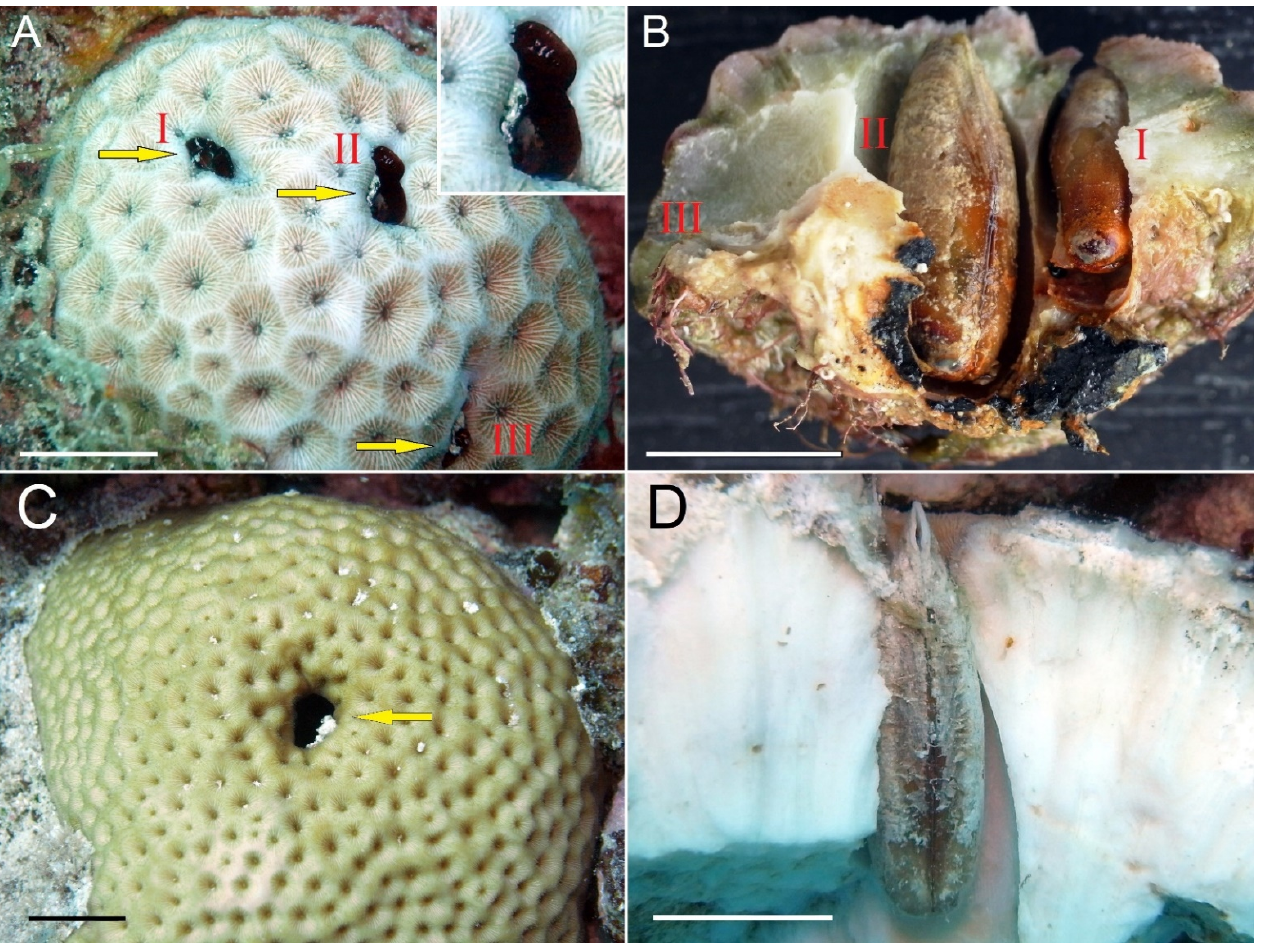
Figure 1. Coral colonies of Siderastrea siderea at Curaçao, showing the position of borehole openings ( A , C : arrows) and Leiosolenus mussels underneath them ( B , D ). One coral contains three mussels ( A , B : I–III) and the other only one ( C , D ). Each exposed mussel has the posterior side upward, showing either a lateral side ( B ) or the dorsal side ( D ). The dark color of each hole ( A , C ) indicates the presence of the mussel’s mantle tissue; in some individuals approaching dark Bordeaux red ( A : insert 2× enlargement). The mantle tissue may be covered by some detritus particles ( B , D ). In exposed mussels, the mantle tissue is retracted inside the shell ( B , D ). Scale bars: 1 cm.